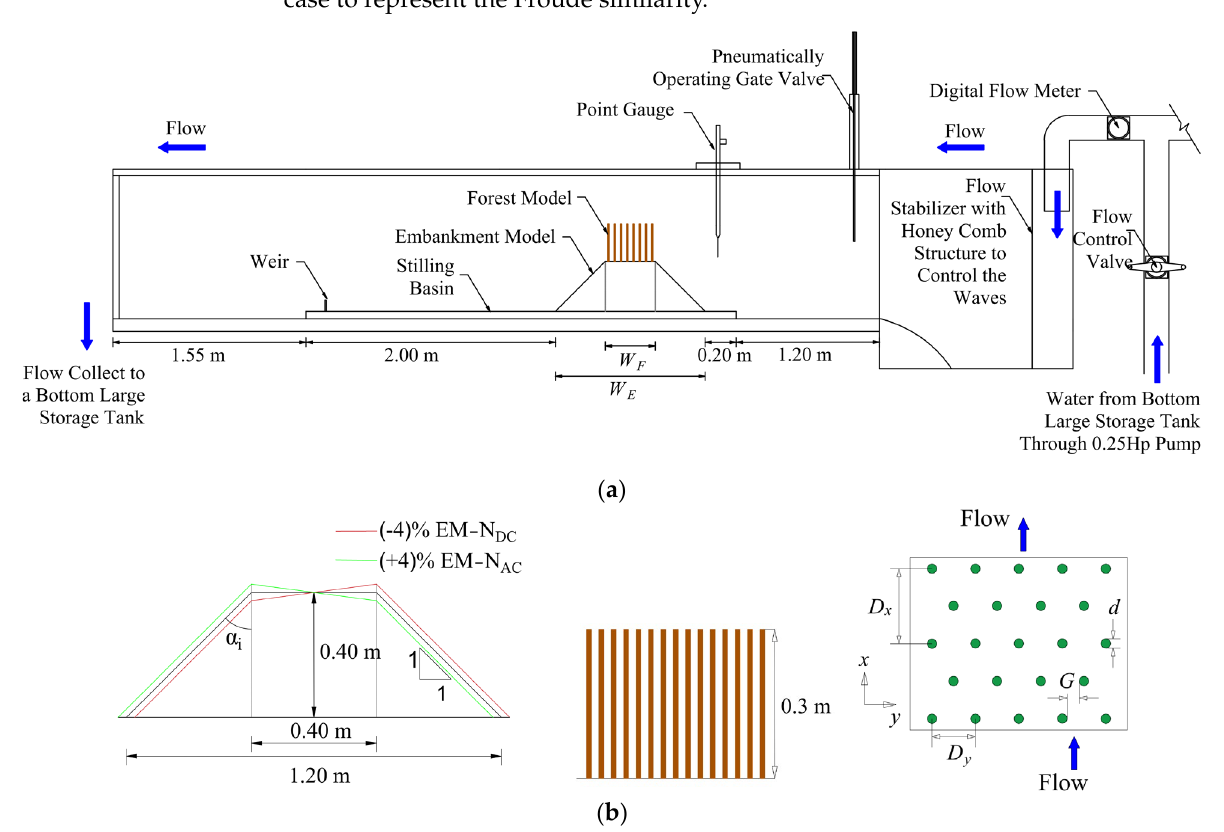
Figure 2. Schematic detail of the experimental setup inside the channel: ( a ) a side view of the experiment flume with embankment (EM) and vegetation model (VM), ( b ) an embankment model (EM), a side view of the vegetation model (VM), and a plan view of the vegetation model arrangement. Table 2. Summary of the experimental conditions and vegetation